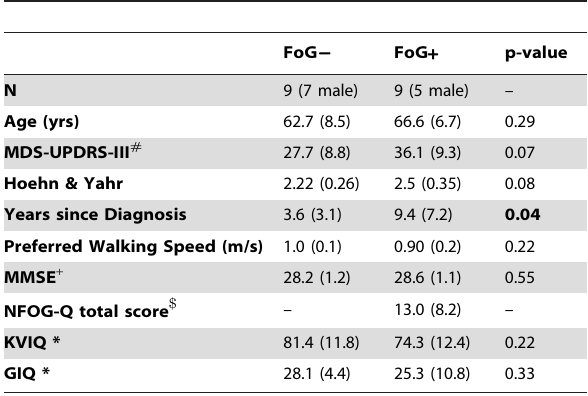
Table 1. Participant